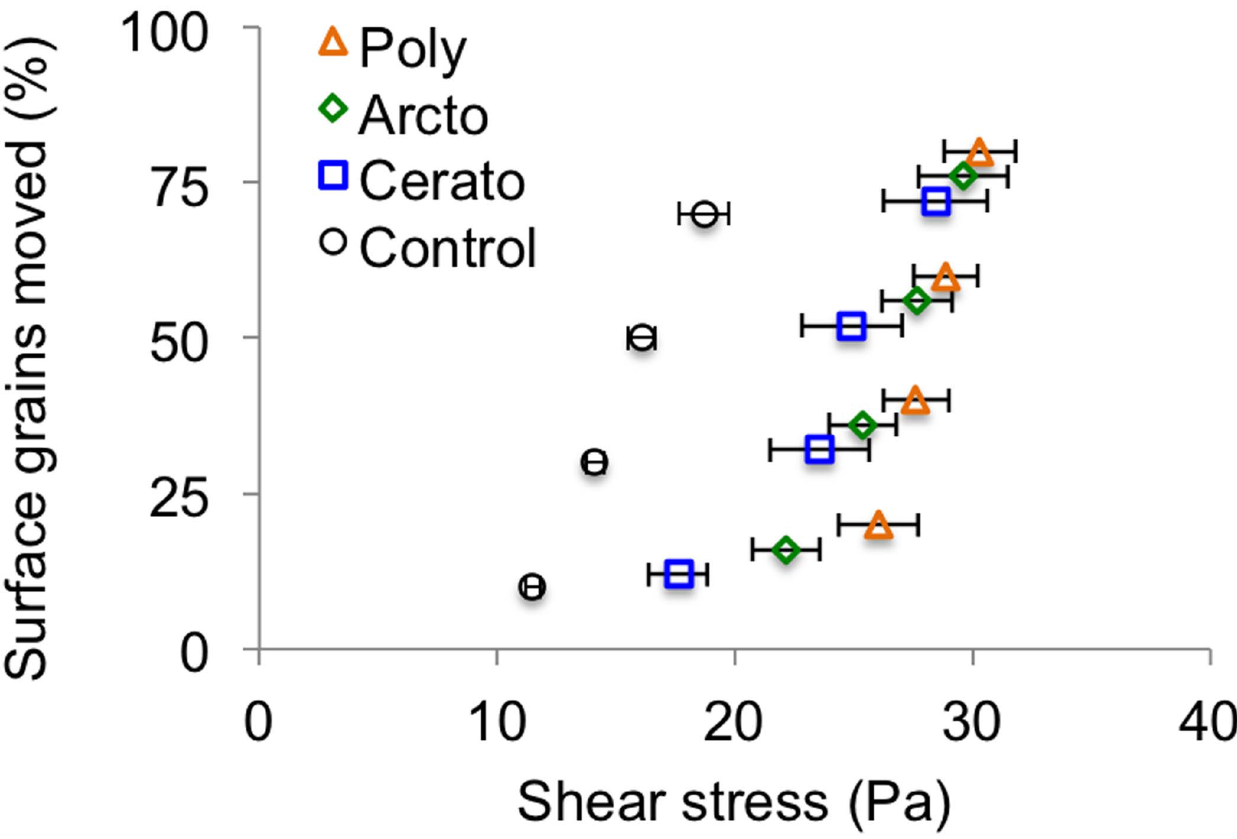
Figure 4. The effect of caddisfly mono.- vs.polycultures on shear stress as the bed eroded beyond the critical shear stress. Values are means of N=8 replicates 6 1 SEM.